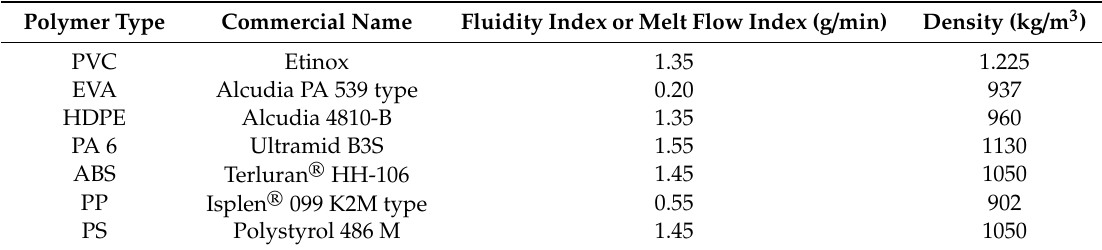
Table 1. Commercial name, fluidity index, and density for each material.